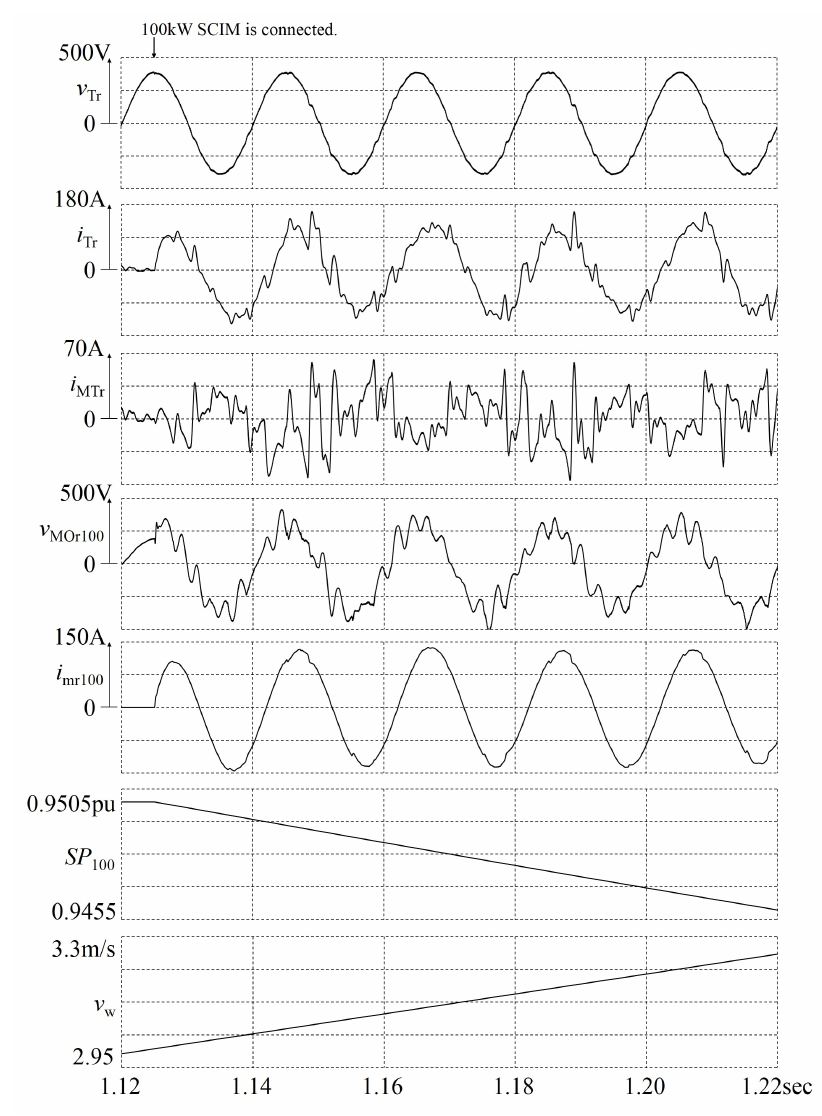
Figure 17. Simulation results with the proposed inrush current suppressor for the 100-kW SCIM when turn ratio is